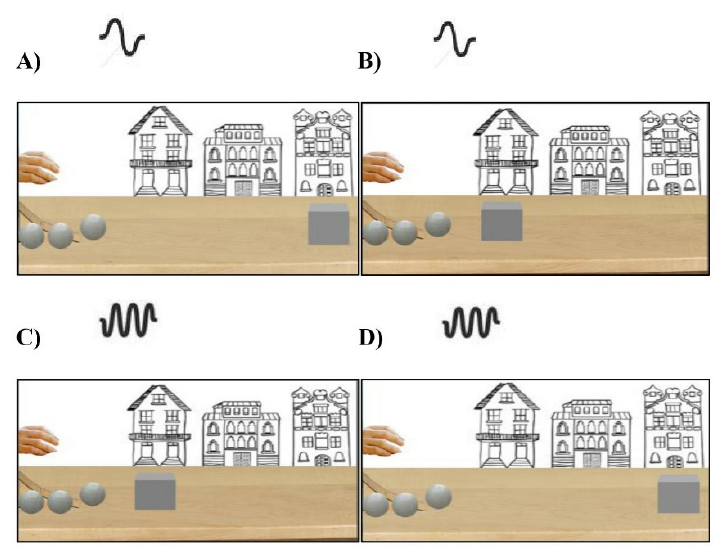
Figure 3. From top to bottom: Top: ( A ) Low pitch likely, ( B ) Low pitch unlikely, Bottom: ( C ) High pitch likely, ( D ) High pitch unlikely event.